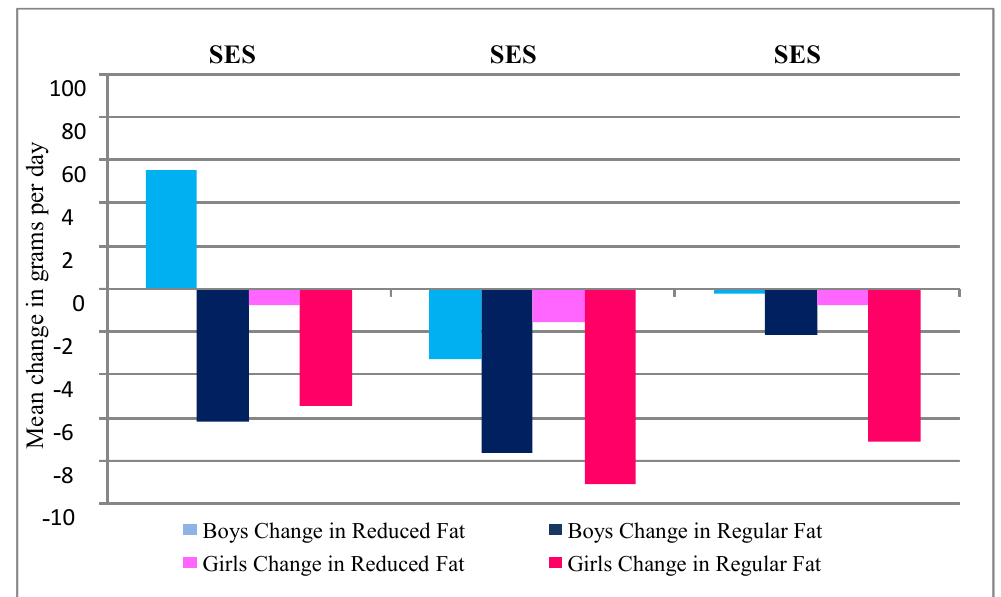
Figure 3. Mean change in grams of total, reduced fat and regular fat dairy in grams per